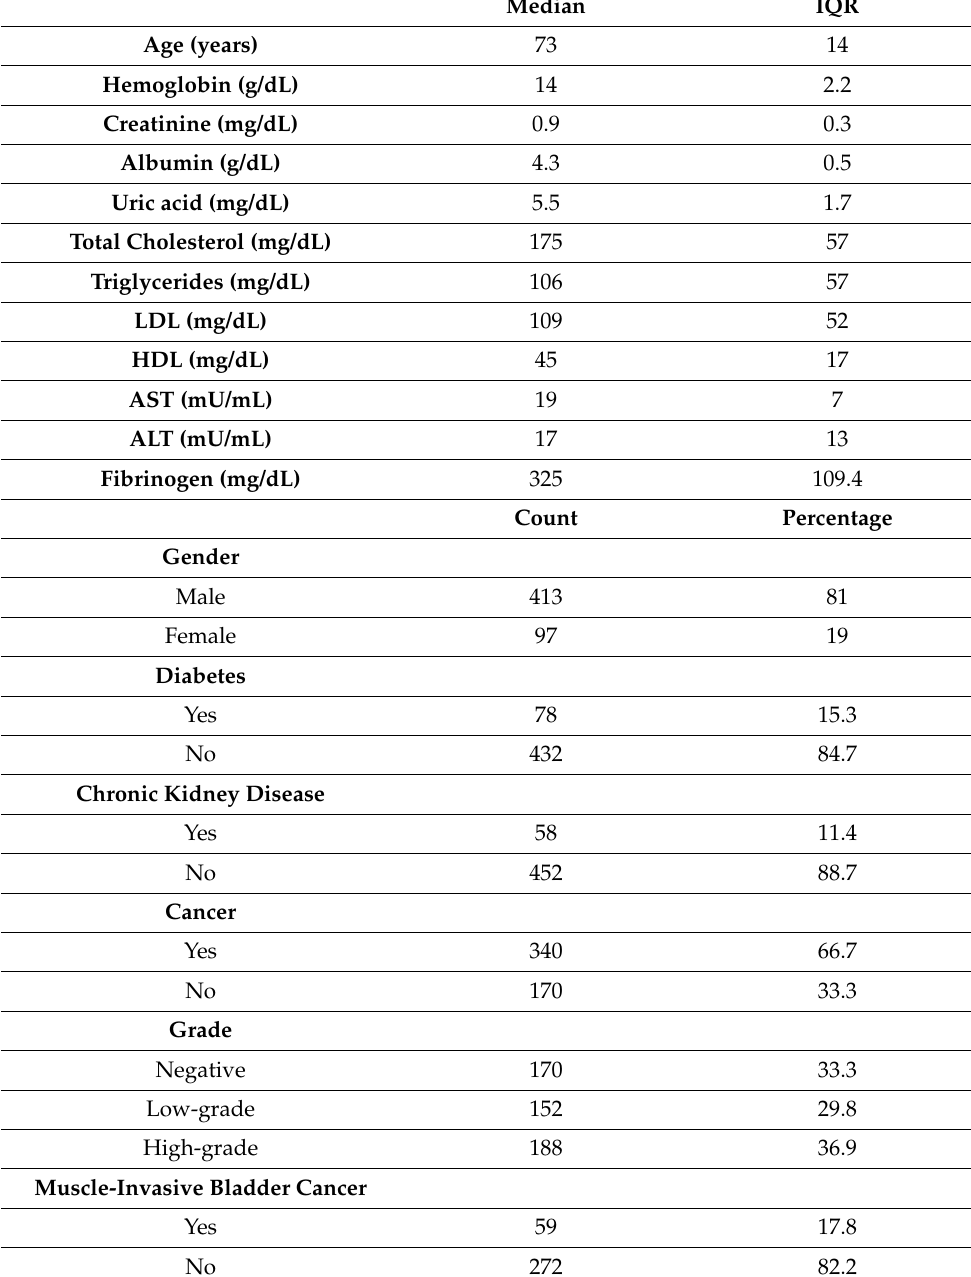
Table 1. Descriptive characteristics of patients involved (IQR: interquartile